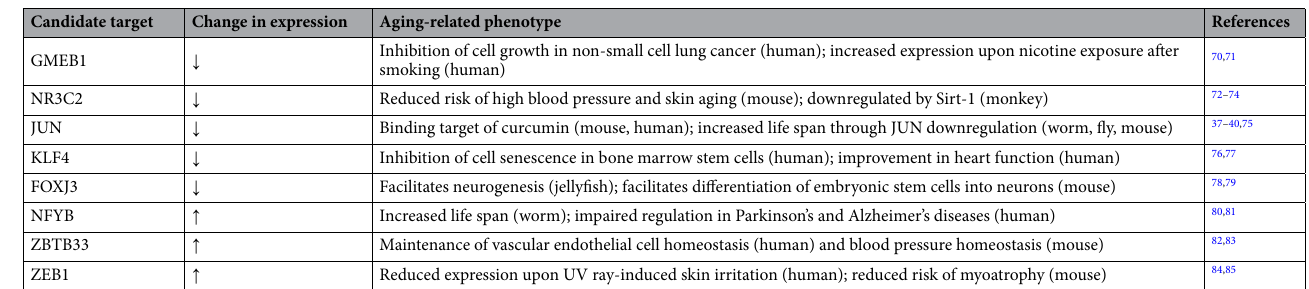
Table 1. Supporting evidence from the literature regarding candidate genes that regulate